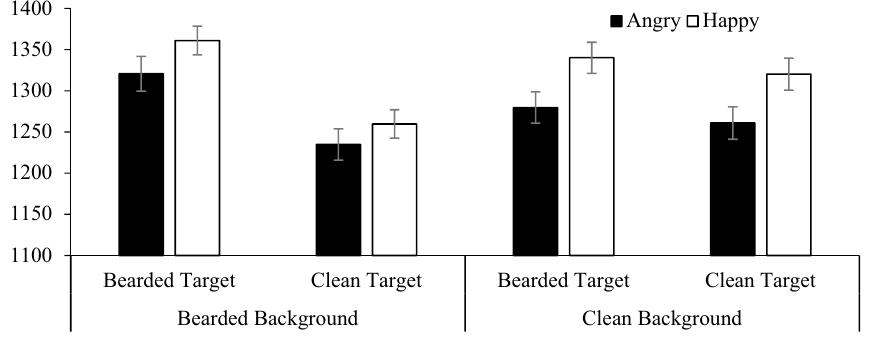
Figure 7. Mean response times (± 1 SE) for Study 3 indicating the presence of target angry or happy expressions, that are bearded or clean-shaven, in backgrounds of uniformly bearded and clean-shaven faces.